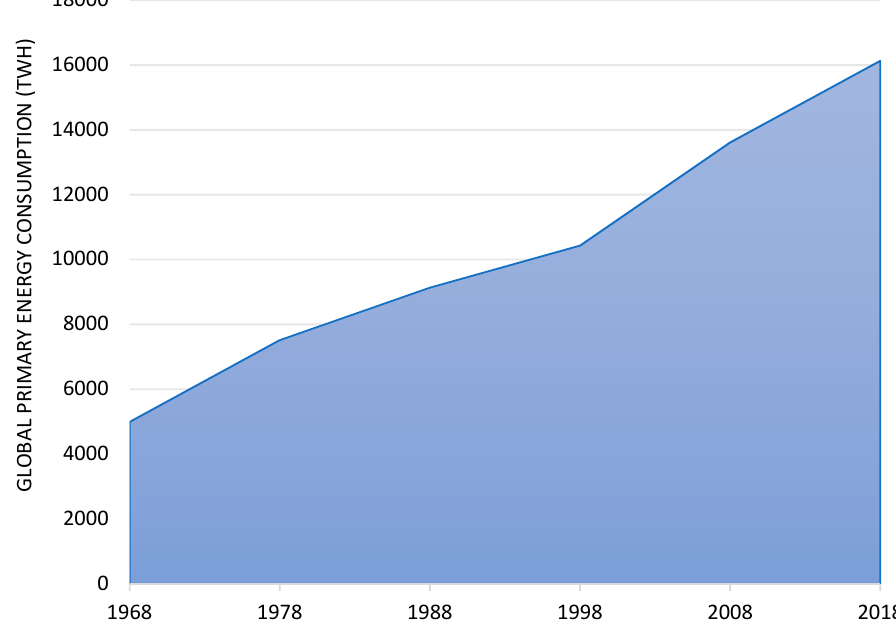
Figure 1. Global fossil fuel consumption between 1968 and 2018 [2,3].